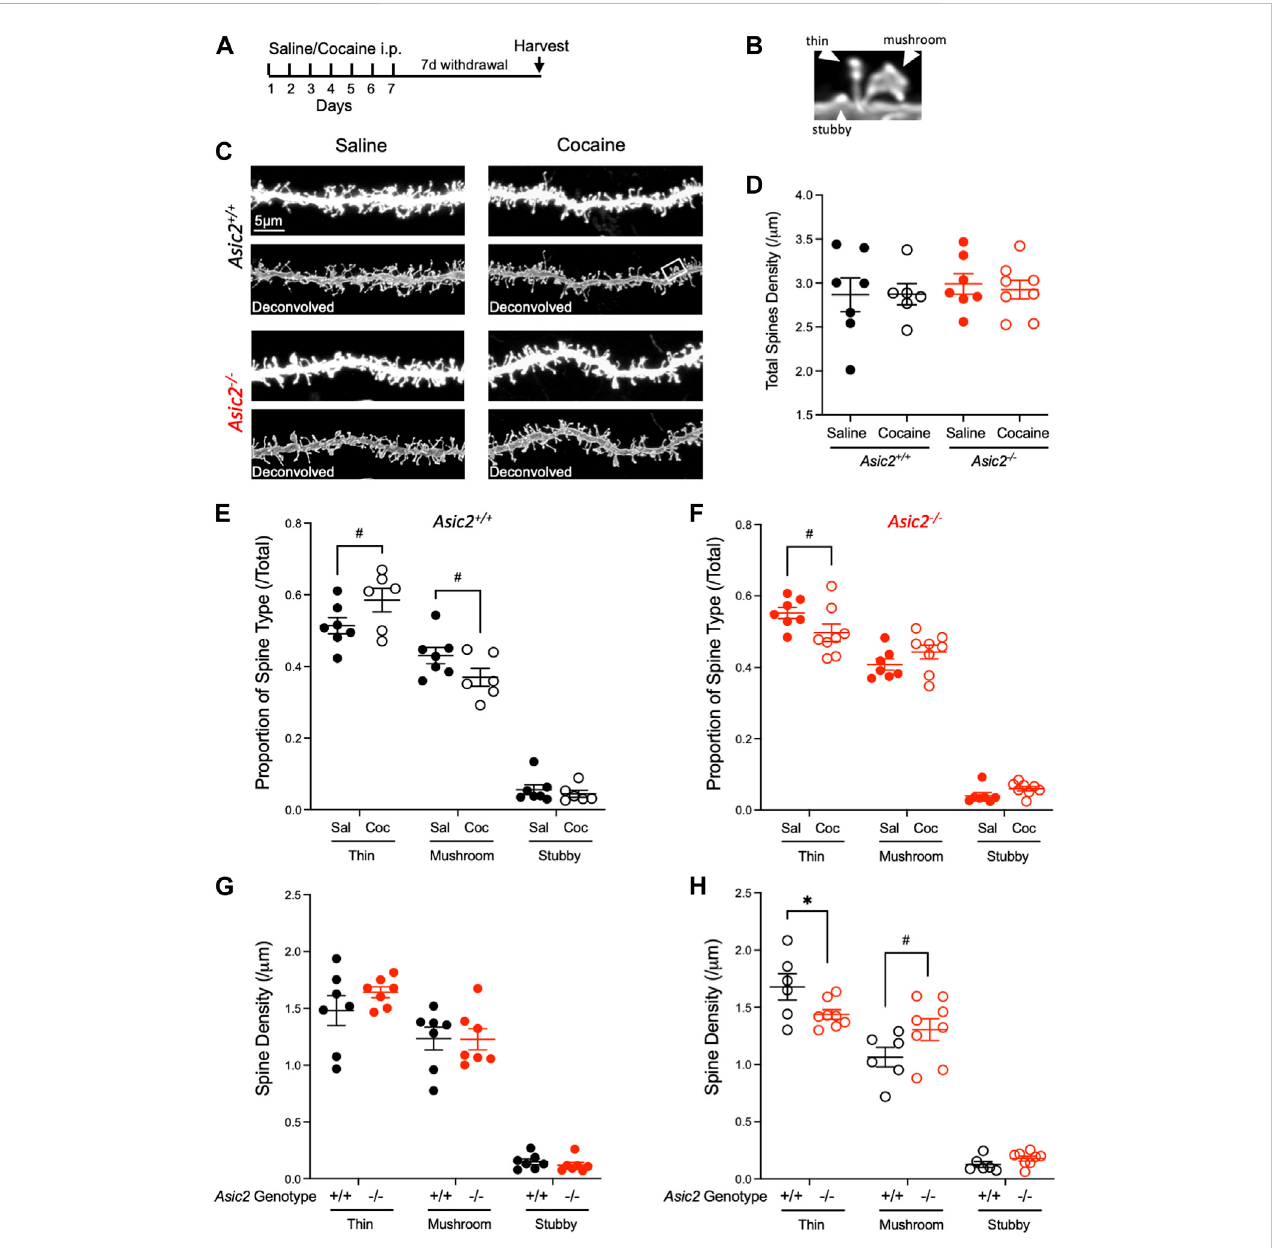
FIGURE 5 ASIC2 disruption interacted with cocaine withdrawal to produce a shift in spine type that was opposite of withdrawal effects in wild-type mice. (A) Timeline of saline or cocaine home cage injections. (B) Examples of spine type designations, thin, stubby and mushroom. (C) Representative images of NAcc dendrites from wild-type and Asic2 − / − MSNs after saline injections or cocaine withdrawal before and after deconvolution. The white rectangle shows the spines in (B) . (D) There was no effect of genotype or drug withdrawal on total dendritic spine density in NAcc via two-way ANOVA and no interaction [F (1,24) = 0.4099, p = 0.5281 genotype effect; F (1,24) = 0.04724, p = 0.8298 drug effect; F (1,24) = 0.06432, p = 0.8019 interaction, n = 6 – 8 mice]. (E) Proportion of each spine type out of total spine density in wild-type mice. An ordinary two-way ANOVA revealed an interaction between cocaine withdrawal andspinetypedistributioninwild-typemice[F(2,33)=4.508, p =0.0186, n =6 – 7mice].Signi fi cancebarsshow p valuesforStudent ’ st-testswhentherewasa trend ( p -value ≤ 0.10, designated #). [t (11) = 1.832, Student ’ s t -test, p = 0.0942 thin spines; t (11) = 1.798, Student ’ s t -test, p = 0.0997 mushroom spines]